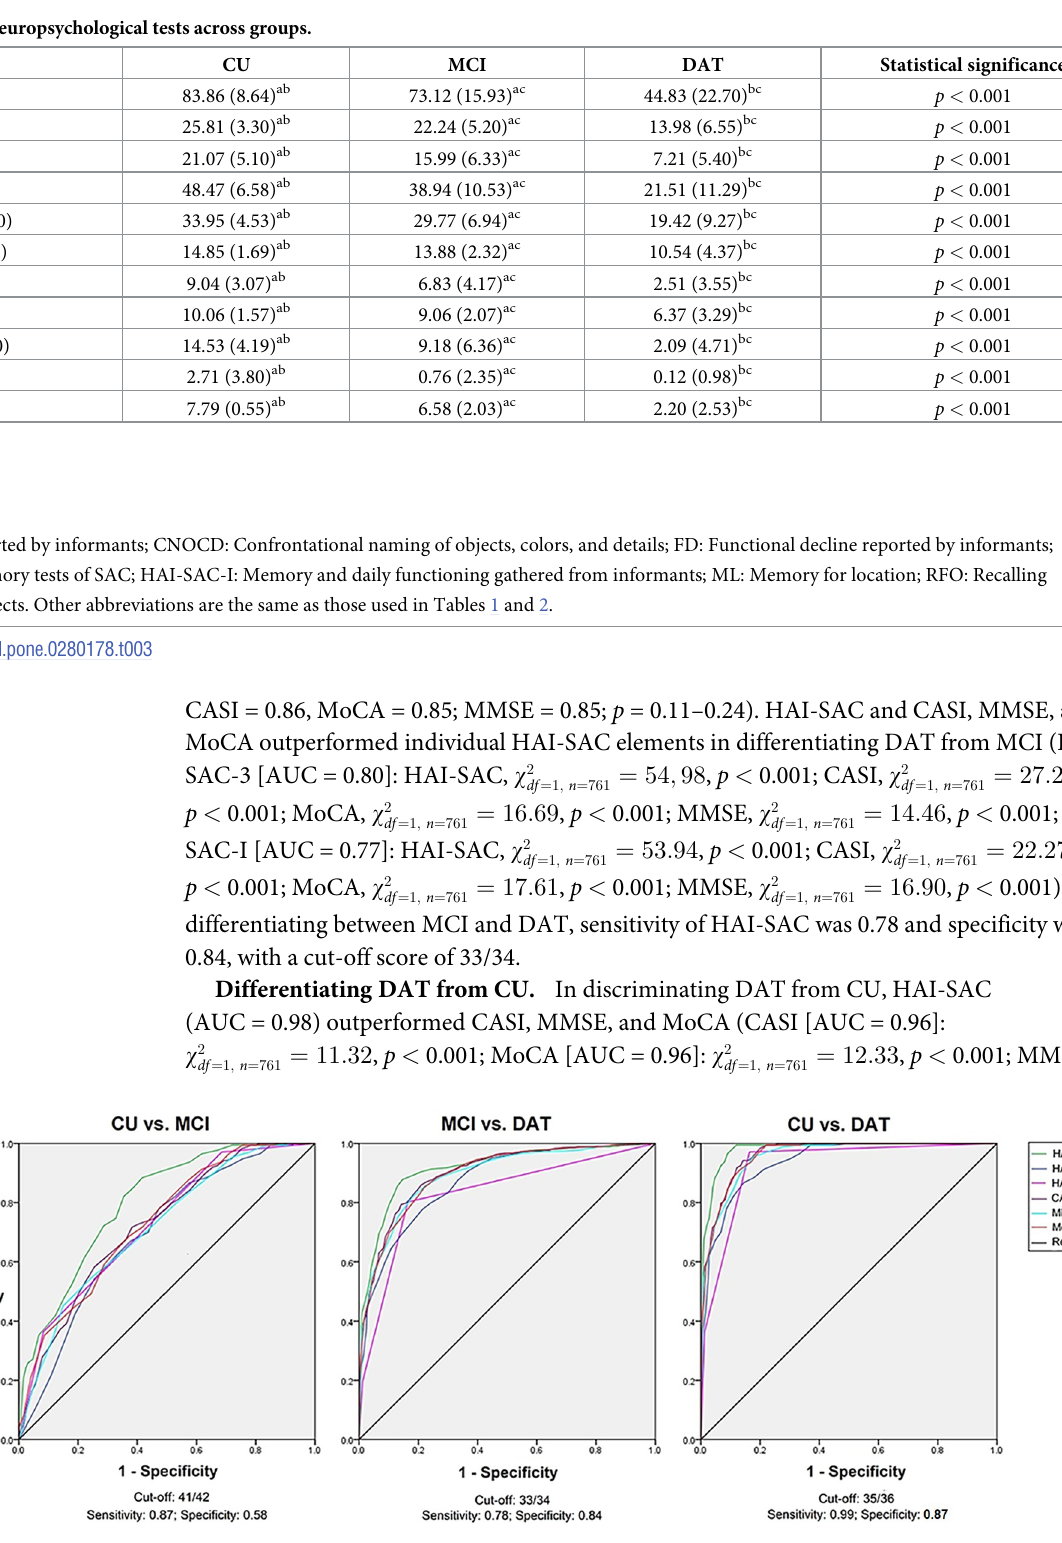
Fig 1. ROC curves across the screening neuropsychological tests. Abbreviations are the same as those used in Table